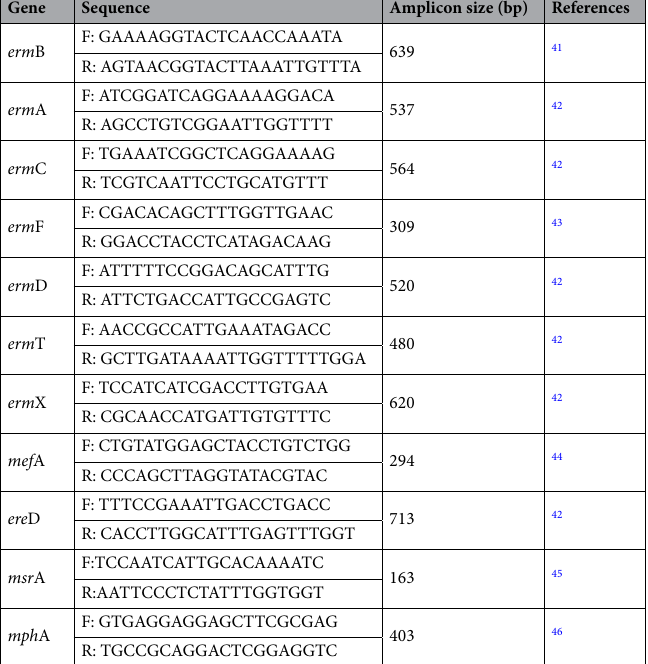
Table 1. Oligonucleotide primers used to amplify erythromycin resistance